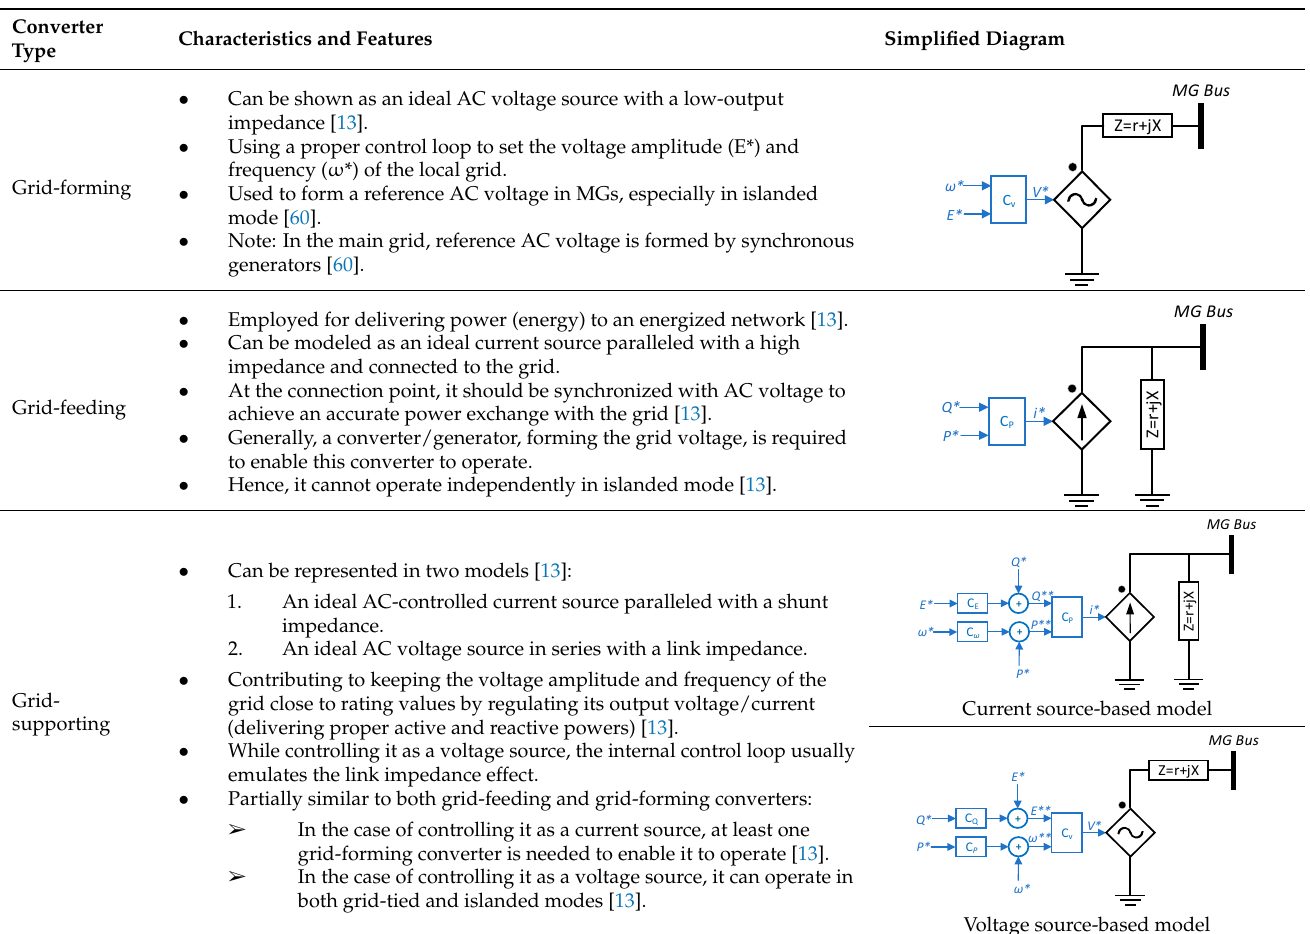
Table 7. Main characteristics of different types of power converters used in ACMGs with their simplified circuit diagrams.